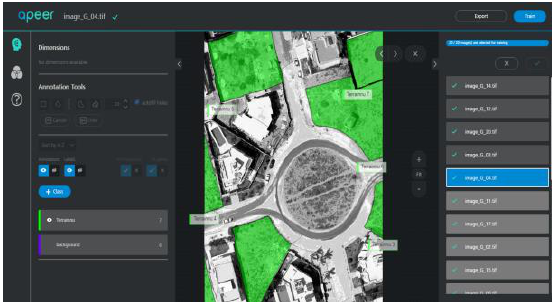
Figure 4 . Example of an image annotation on APEER.